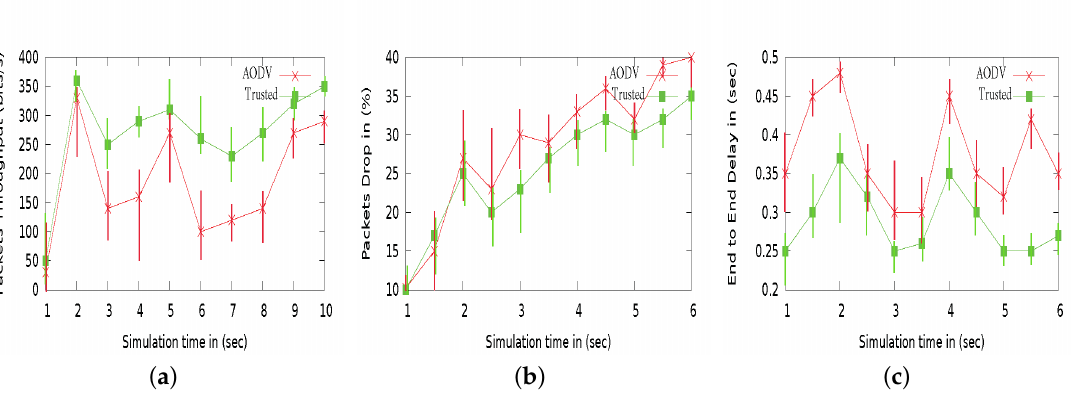
Figure 10. Effects of proportions of On-off attackers on the performances with parameter R = 250 m, V = 5 m/s, and N = 20: ( a ) Packet throughput ( b ) Packet drop ratio. ( c ) End-to-end delay.